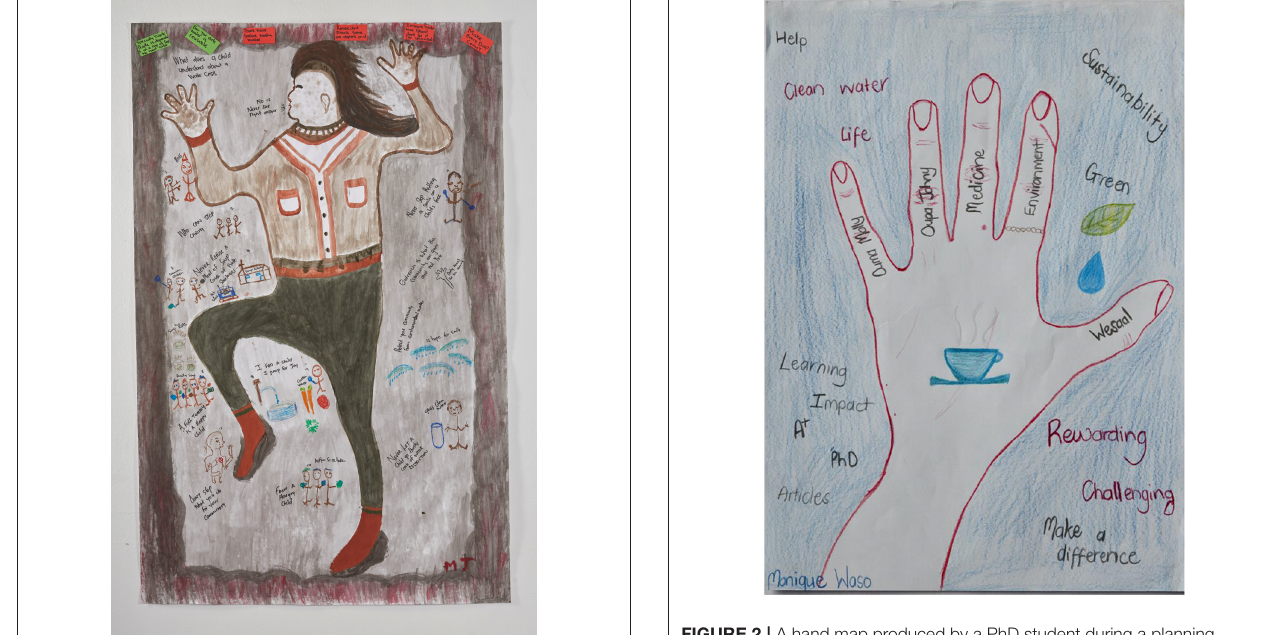
FIGURE 1 | A body map describing the personal experiences and perceived implications of the 2018 Cape Town water crisis, produced by a community participant during the five-day creative workshop in Delft.